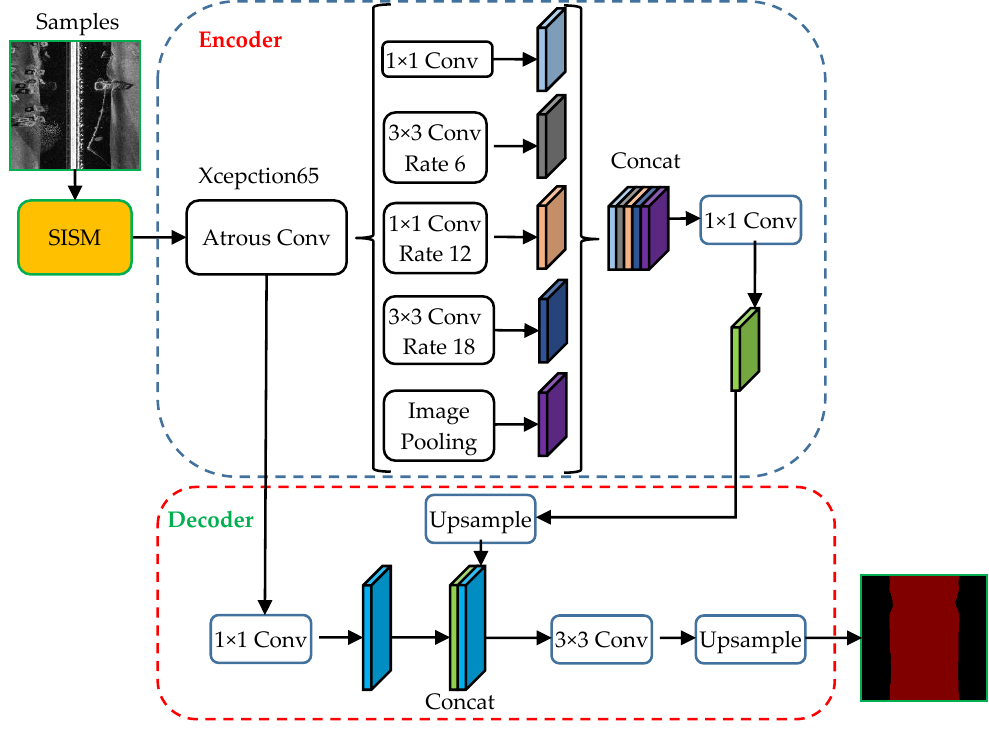
Figure 5. Complete semantic segmentation network structure. The proposed SISM is add to the head of the network. The encoder module encodes multi-scale contextual information by applying atrous convolution at multiple scales, while the decoder module refines the segmentation results along object boundaries.